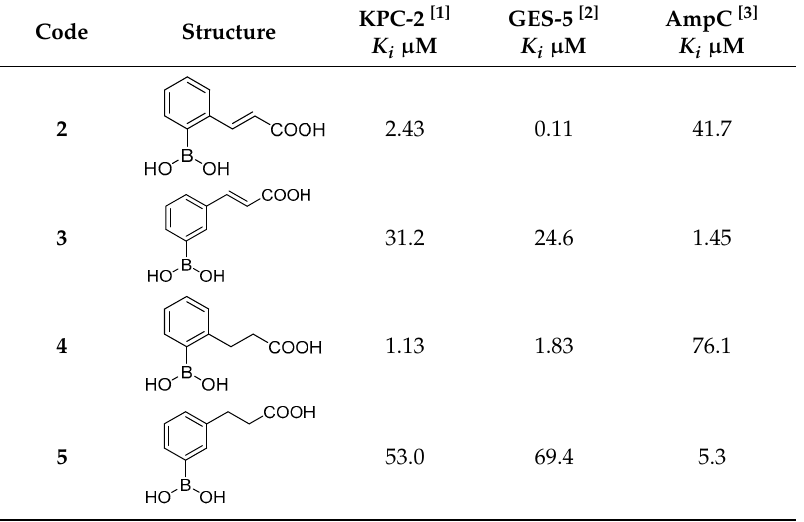
Table 1. Inhibitory profile of phenylboronic acids against Serine β -Lactamases of Class A and C. Code Structure